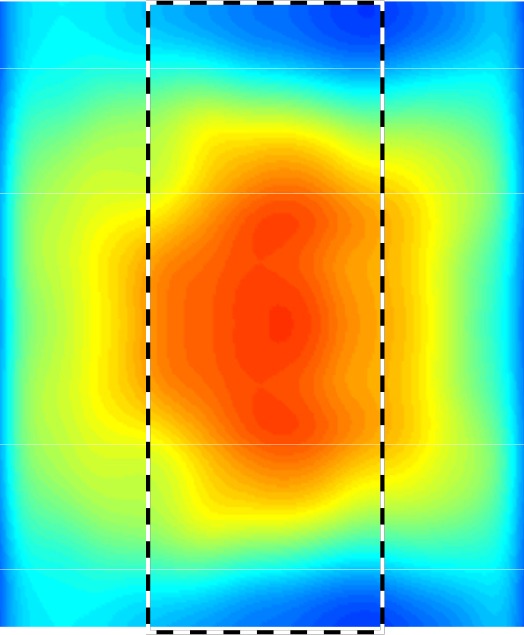
Isotropic basal myosin, (as main text Figure 1g).Dashed box indicates region used to evaluate DV asymmetry.